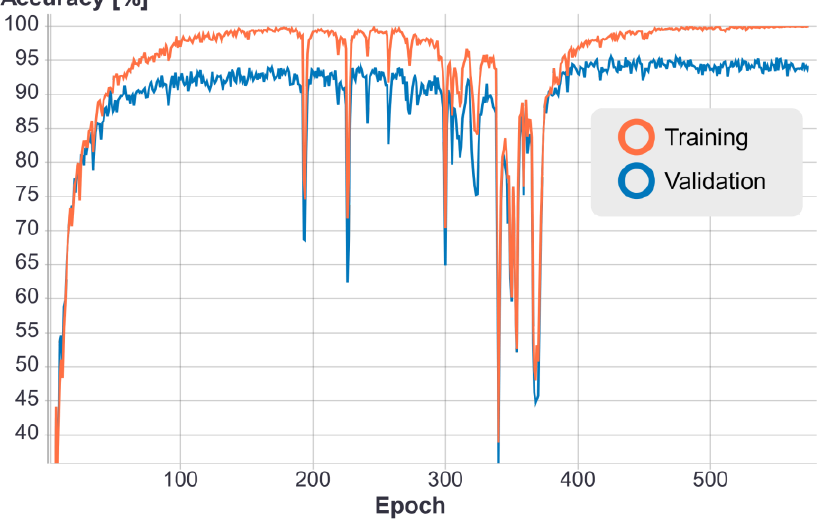
Figure 8. Neural network accuracy during training. Accuracy is defined as the percentage of triplets satisfying the triplet loss margin condition in a randomly sampled batch of 2048 triplets.